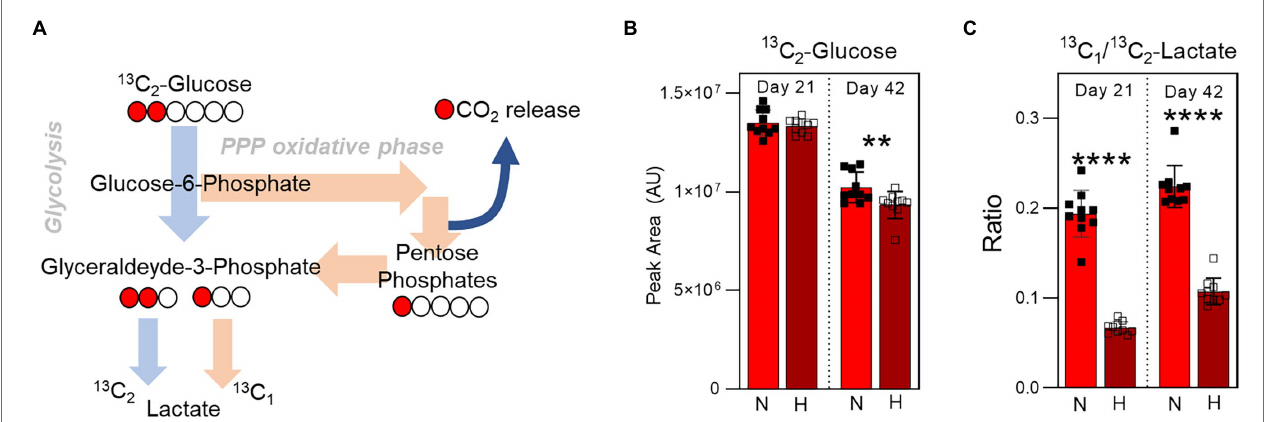
FIGURE 6 | Isotope tracing analysis to disentangle glycolysis vs. pentose phosphate pathway utilization. (A) The labeling scheme of 13 C 1,2 -Glucose is shown, which depicts the relative contribution of 13 C 2 -lactate and 13 C 1 -lactate to the total lactate pool by glycolysis and the pentose phosphate pathway, respectively. (B) The relative levels (in peak area, arbitrary units) of 13 C 2 -Glucose at Day 21 (left) and Day 42 (right) in RBC stored under normoxic (light red) or hypoxic (dark red) conditions. (C) The ratio of 13 C 1 -lactate to 13 C 2 -lactate in the same samples. p -values from a two-tailed paired T-test comparing normoxic and hypoxic storage at each time point are indicated as ** p < 0.01; and **** p <